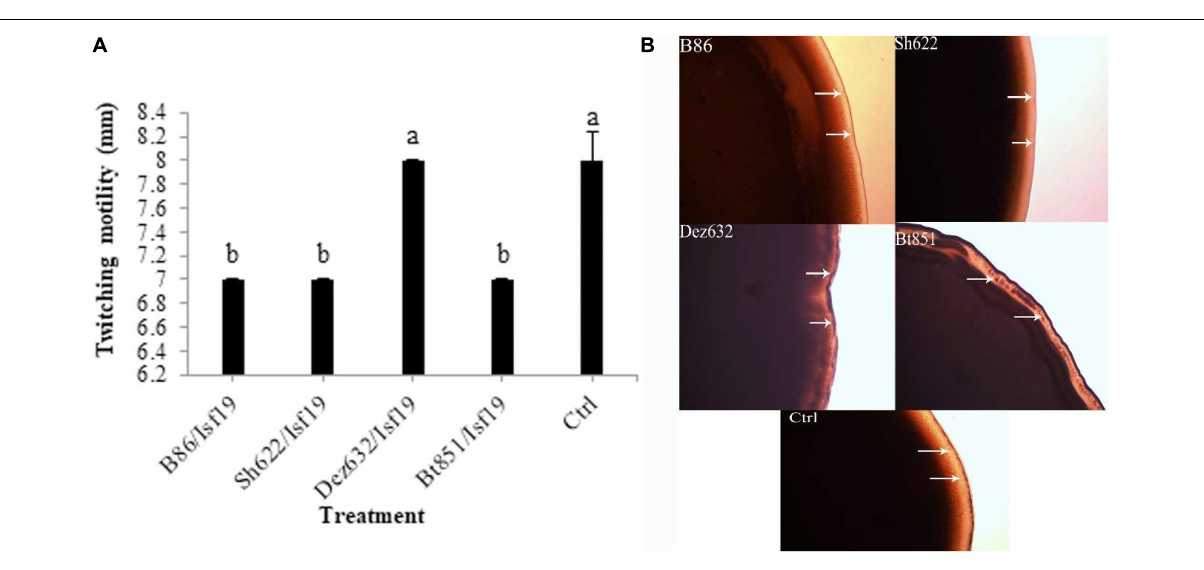
FIGURE 4 | Effects of VOCs produced by Streptomyces sp. B86 , Pantoea sp. Dez632 , Pseudomonas sp. Bt851, and Stenotrophomonas sp. Sh622 on twitching motility of B. pumilus Isf19 compared to the non-treated control (Ctrl). The diameter of motility zone (A) and representative plate of swarming motility assay (B) were shown. Three replicates were used for each treatment. Error bars indicate the SE of the three replicates. Different letters indicate significant differences ( P =